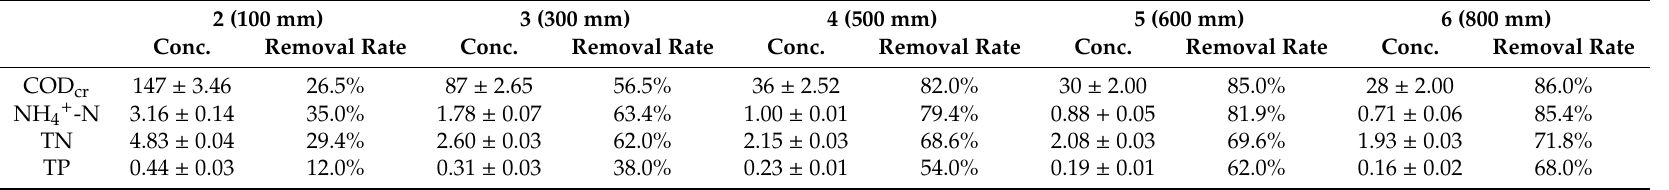
Table 5. Concentration of e ffl uent pollutants at di ff erent depths of bioretention system (unit: mg /